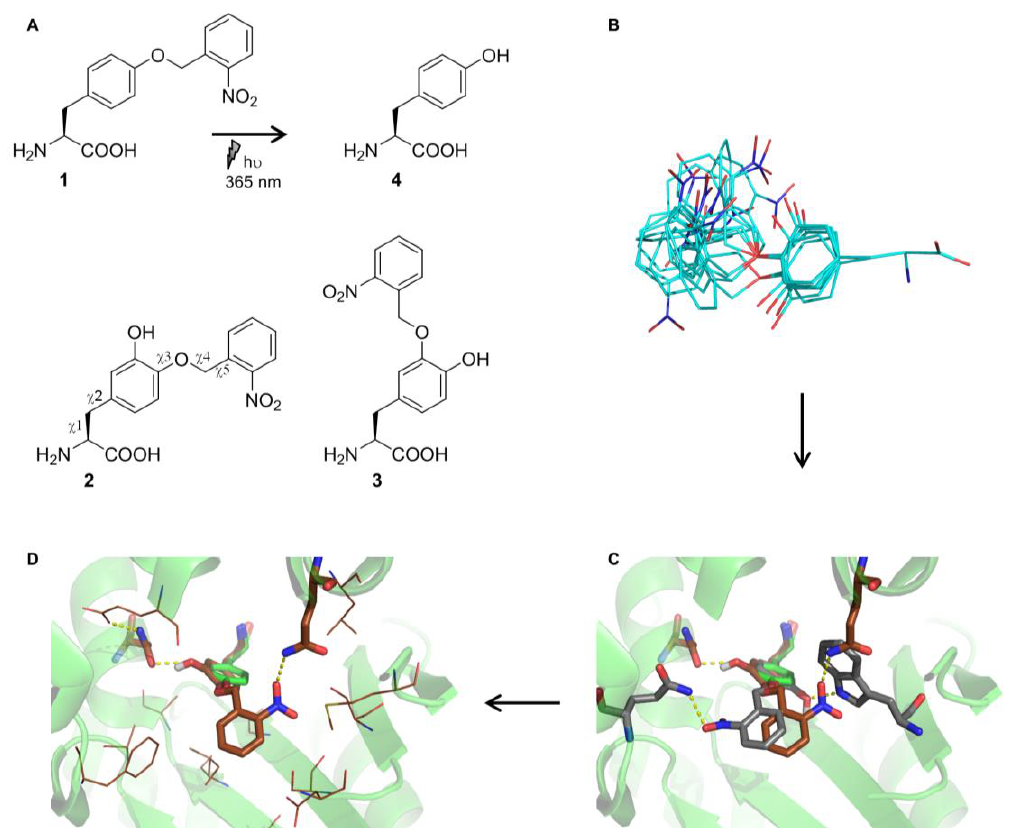
Figure 1. Compounds and computational design process to yield an aminoacyl-tRNA synthetase (aaRS) for genetic incorporation of ortho -nitrobenzyl tyrosine (ONBY). ( A ) ONBY ( 1 ), which can be photocleaved to yield Tyr ( 4 ), as well as chemical structures of meta- and para- ONB-DOPA ( 2 , 3 ). For 2 , rotation angles ( χ 1–5) are indicated. ( B ) Noncanonical amino acid (ncAA) ensemble of 2 diversified around χ 3–5, with χ 1–2 as observed in the Mj TyrRS wild type structure (PDB ID 1J1U) with the substrate tyrosine. ( C ) Matching stage of aaRS redesign: The ncAA substrate was placed in the 1J1U active site in orientations such that the core part overlaps with the substrate tyrosine (shown in green) and where specific interactions with the new polar groups can be formed. Two of the generated 143 matches are shown in gray and orange, respectively. ( D ) Design stage: Additional active site residues were redesigned to accommodate both the new ncAA substrate and the matched protein residues.